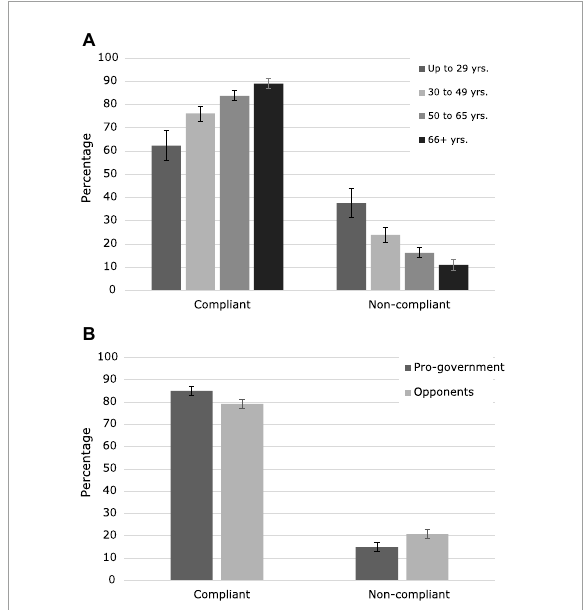
FIGURE2 Compliance with protective health behaviors. (A) Percentage of participants compliant with protective health behaviors according to age group. (B) Percentage of participants compliant with protective health behaviors according to political orientation. Error bars represent bootstrapped 95% CI.